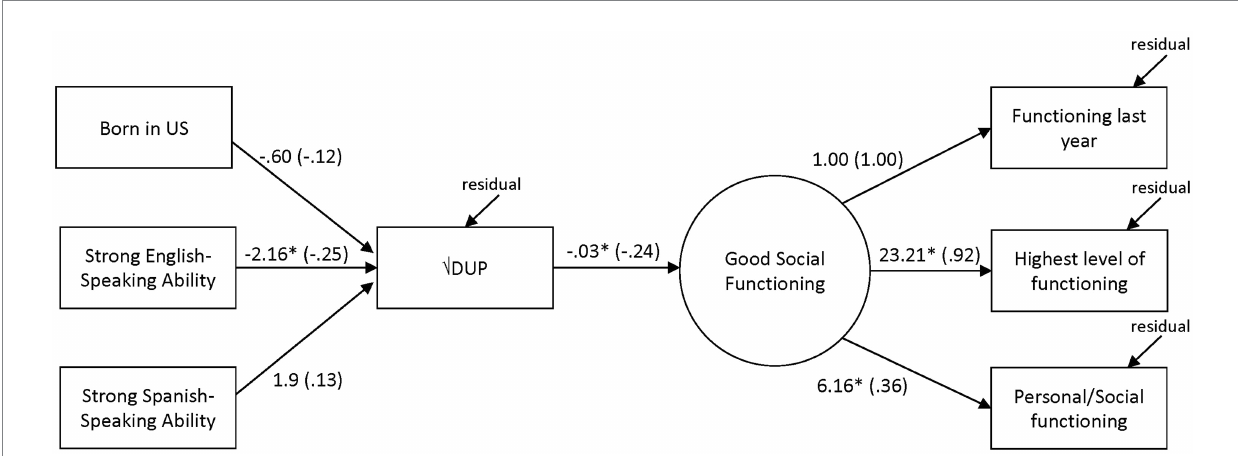
FIGURE 2 SEM of the relationships between determinants, DUP, and social functioning with unstandardized (standardized) coefficients. * p < .05. Rectangles represent observed variables and the circle the latent variable. Observed variables correspond to the following measures: self-reported immigration status (yes/no for born in U.S.), self-reported language proficiency (linguistic proficiency scale of the Bidimensional Acculturation Scale for Hispanics), functioning in the last year (Strauss-Carpenter Level of Function Scale; SC), highest level of functioning (Social and Occupational Functioning Assessment Scale; SOFAS), and personal/social functioning (Personal and Social Performance Scale;